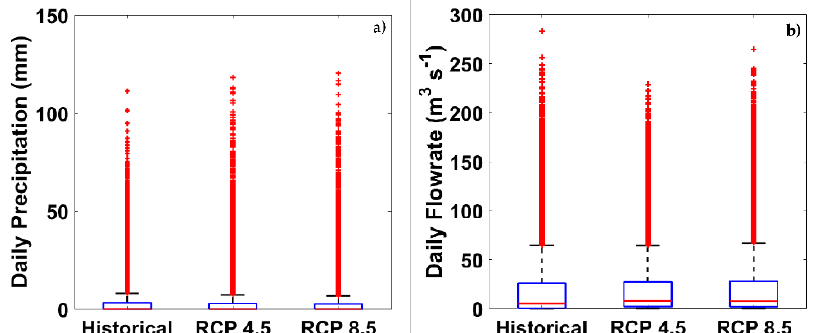
Figure 7. Boxplots of the daily ( a ) precipitation and ( b ) flowrate for the historical (1950–2015) and future scenarios (2041–2070) under RCP4.5 and RCP8.5.